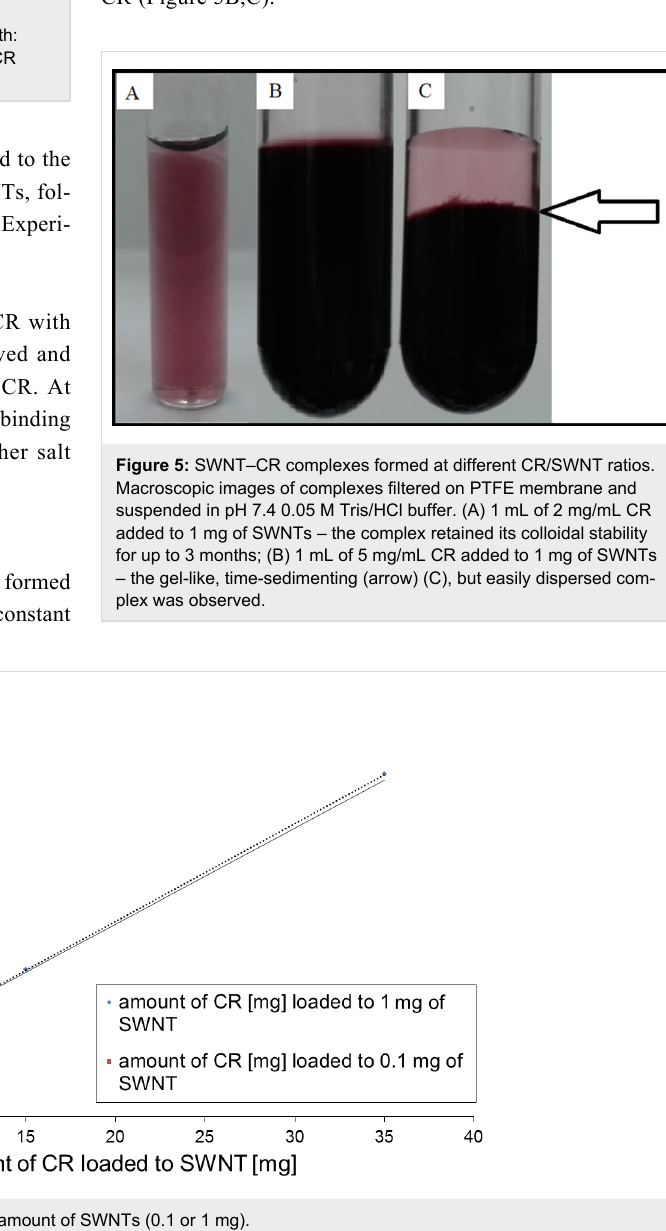
Figure 4: Binding of an increasing amount of CR by a constant amount of SWNTs (0.1 or 1 mg).